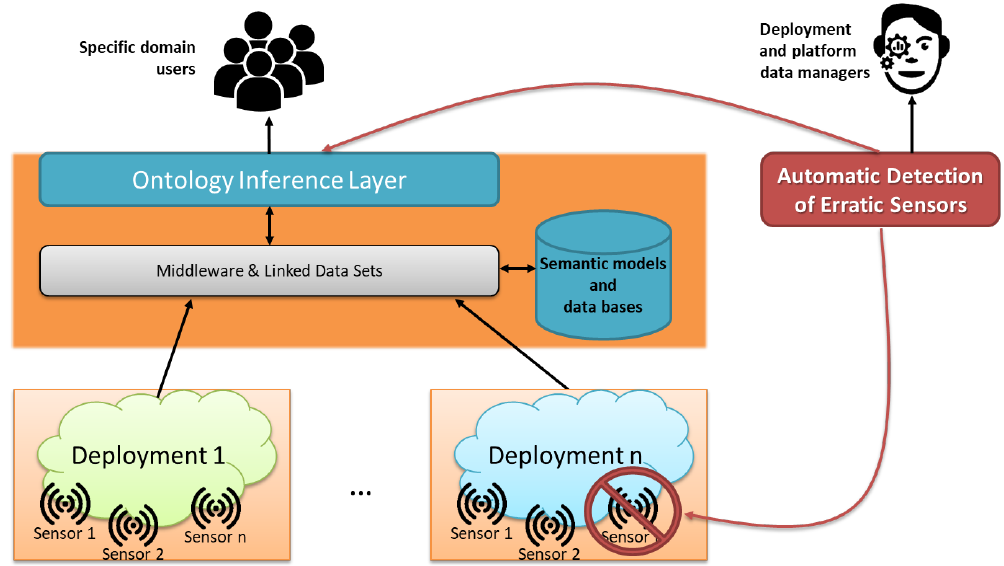
Figure 1. Automatic Detection of Erratic Sensors in an ambient intelligence platform based on semantic